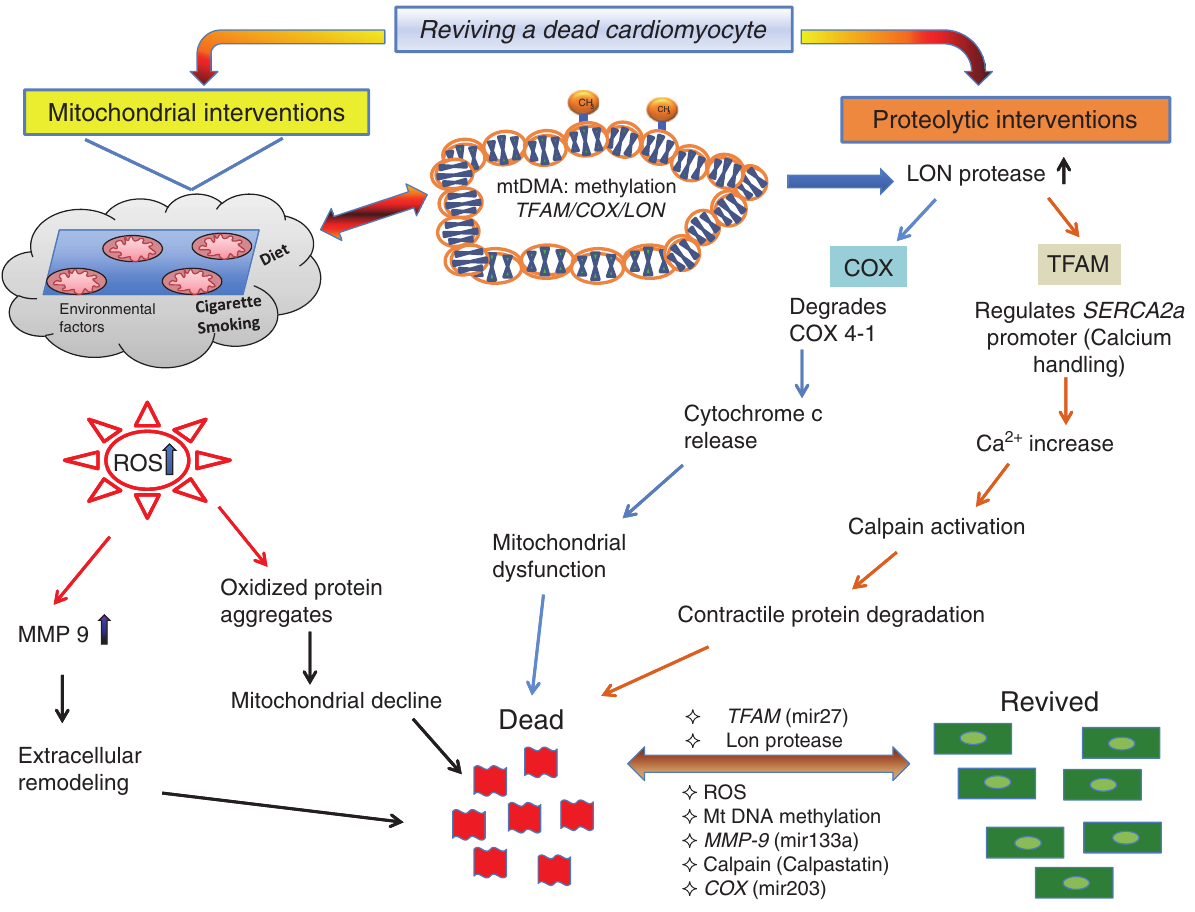
Figure 4: Proposed mechanisms for reviving a dead